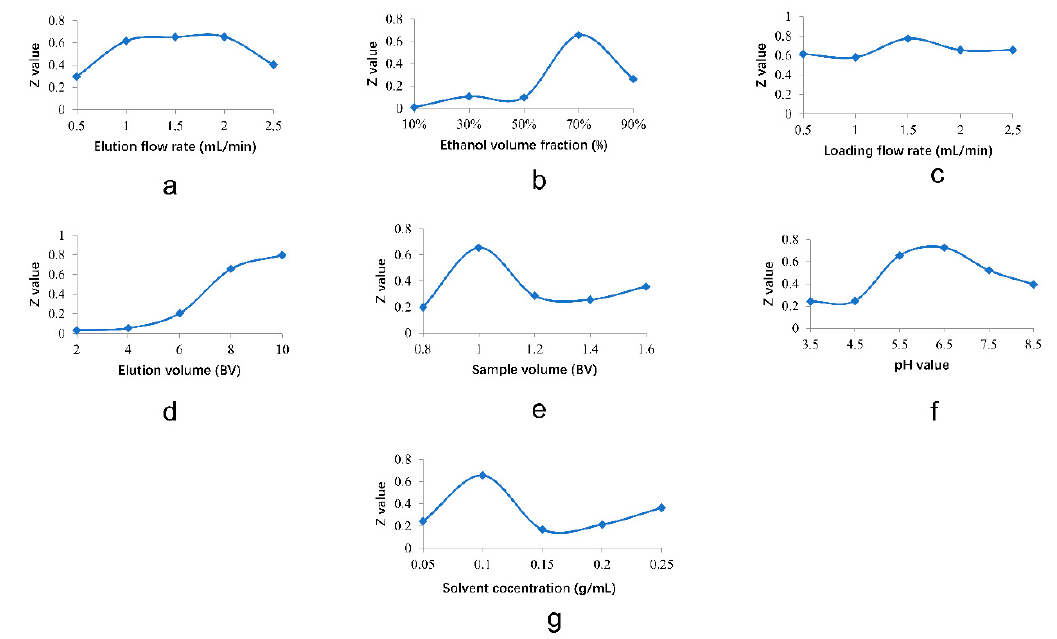
Figure 1. ( a ): Effect of elution volume flow rate on Z value; ( b ): effect of ethanol volume fraction on Z value; ( c ): effect of loading flow rate on Z value; ( d ): effect of elution volume on Z value; ( e ): effect of sample volume on Z value; ( f ): effect of pH value on Z value; ( g ): effect of extraction solvent on Z value.